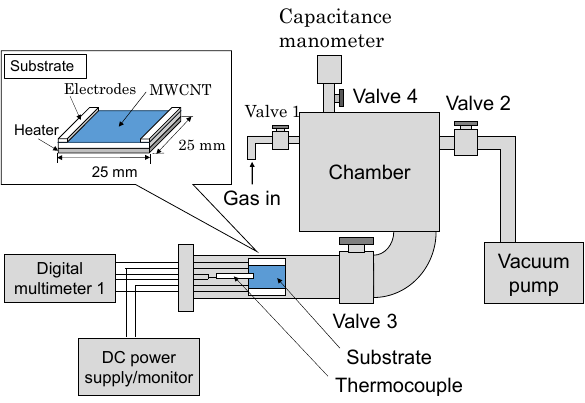
Figure 3. Experimental setup of the measurement system.